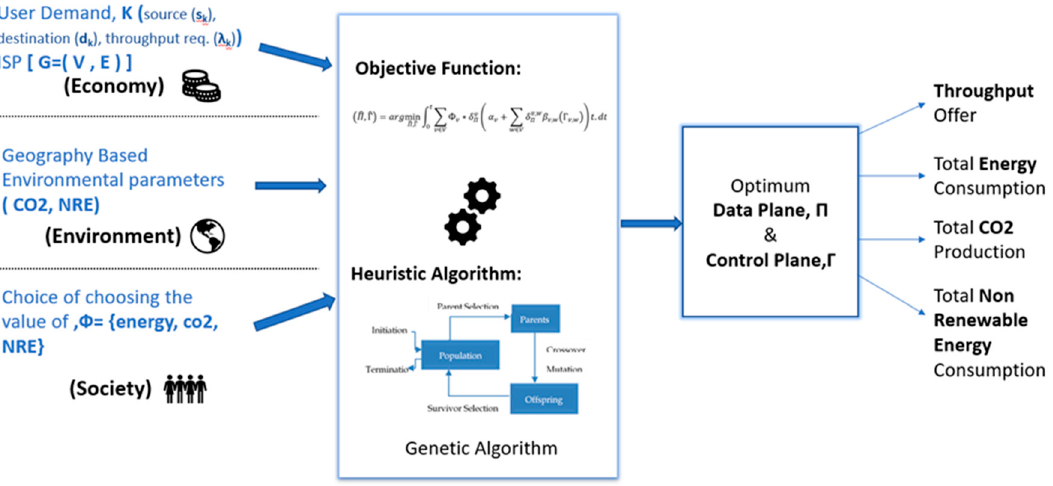
Figure 4. Generation of sustainable data and control plane.